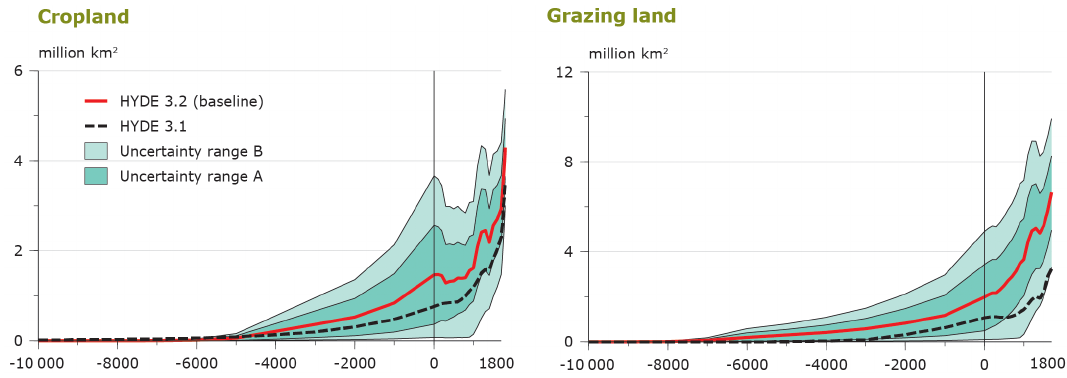
Figure 10. Comparison of HYDE 3.1 and HYDE 3.2, with uncertainty